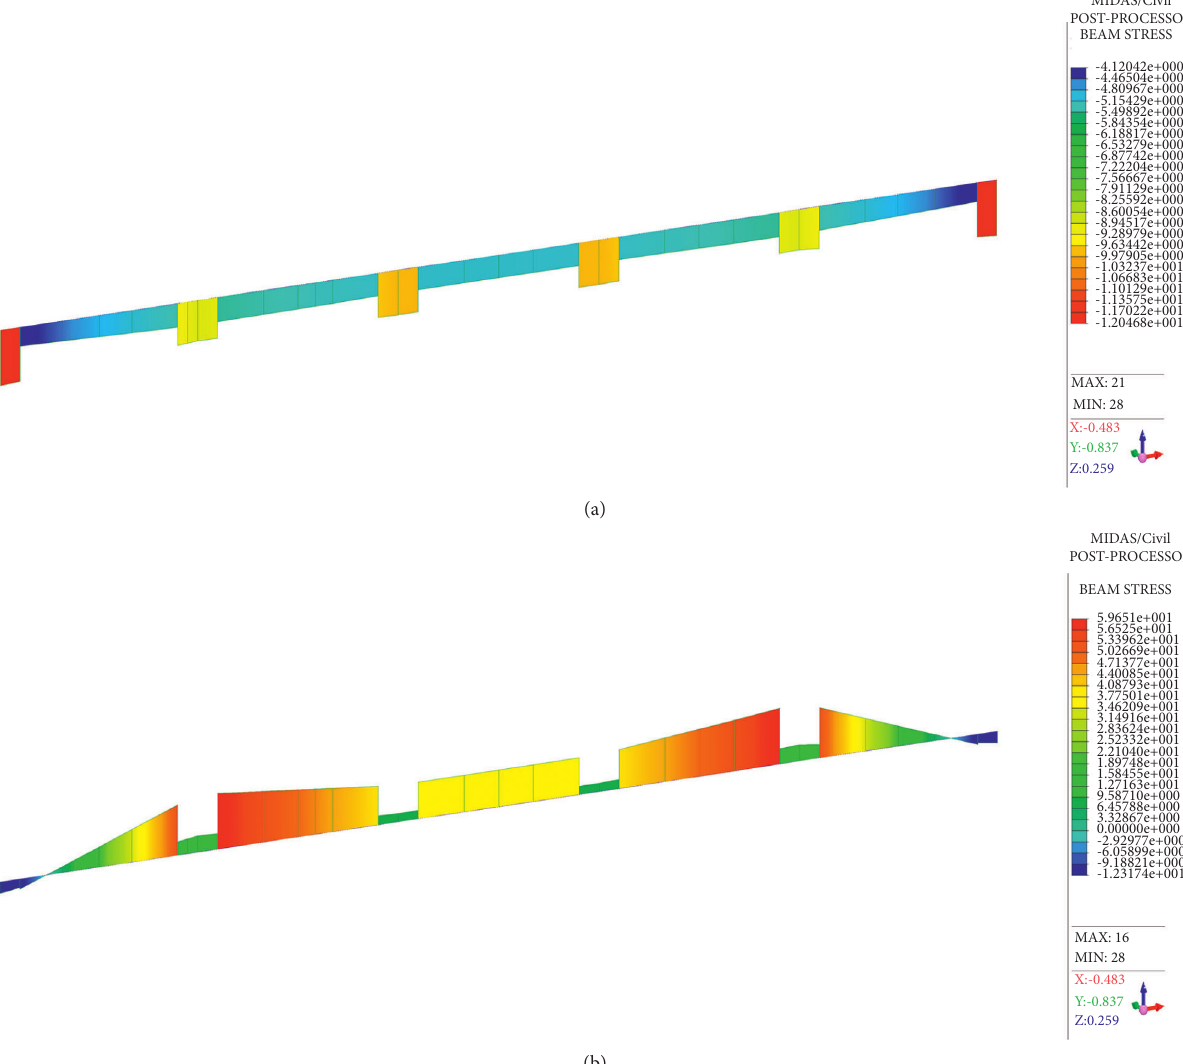
Figure 14: Stress diagram of the steel-concrete composite bridge under a rise gradient. (a) Stress diagram of the concrete deck. (b) Stress diagram of the steel